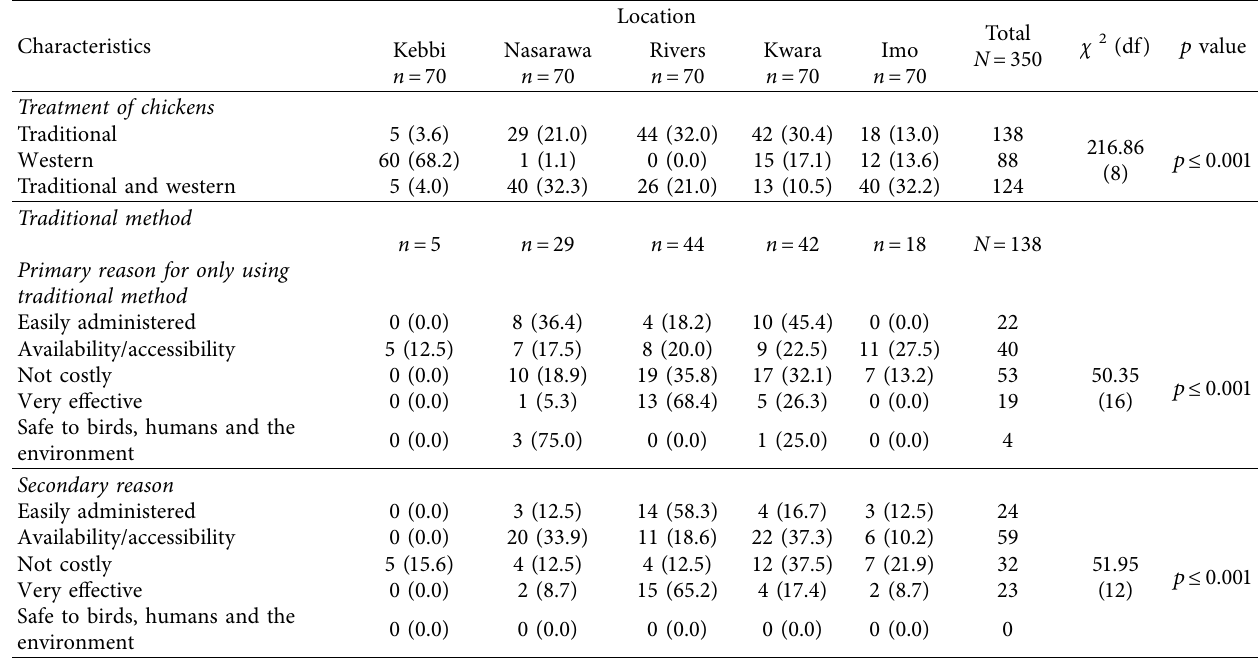
Table 4: Distribution of treatment methods available to